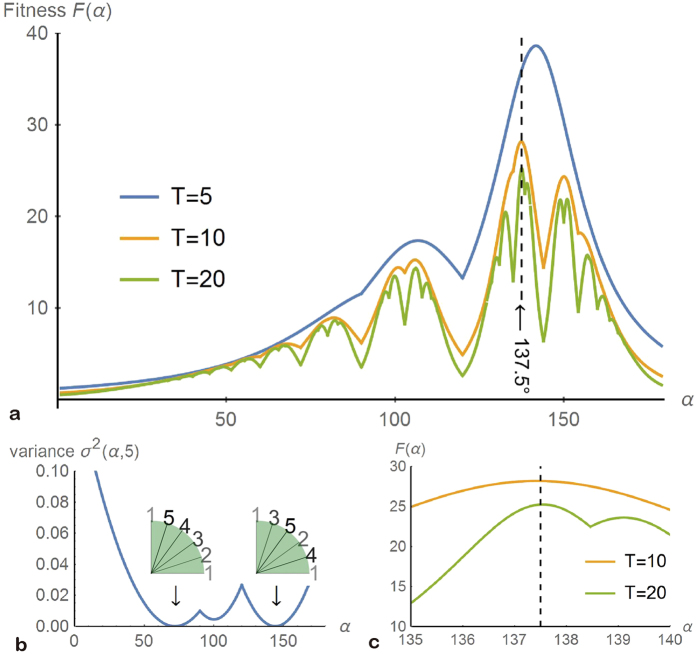
The 137.5° angle is the fittest angle.(a)
F (α) for T = 5, 10, and 20. (b)
σ2(α) for T = 5. (c) Enlargement of (a).